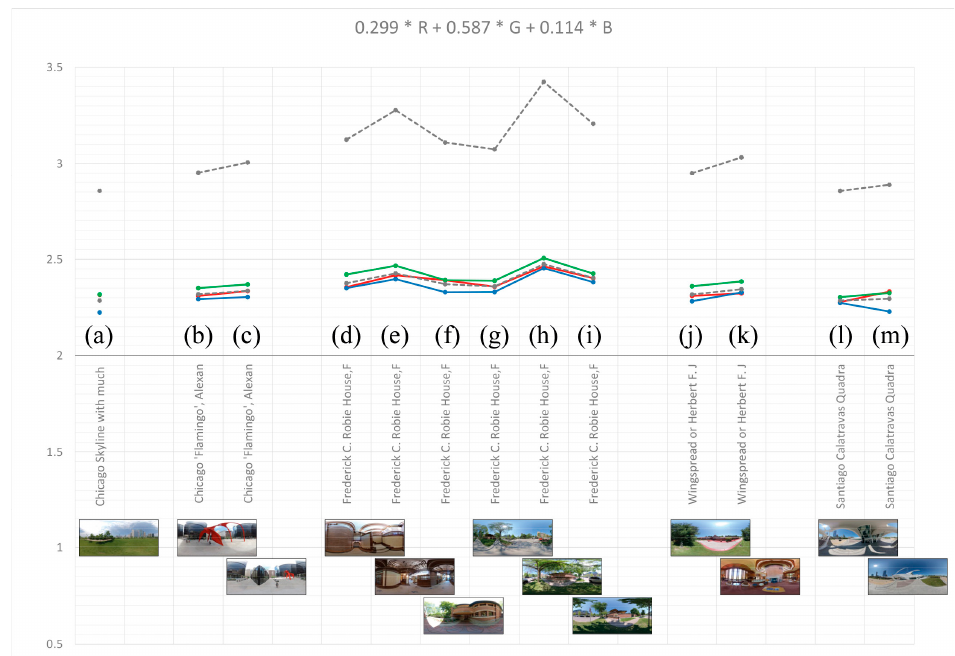
Figure 13. Measurement method “Color DBX M × N ( m × m ) (shifting boxes)” with the weighted grayscale conversion (see Formula (13)) applied to different spherical photographs.